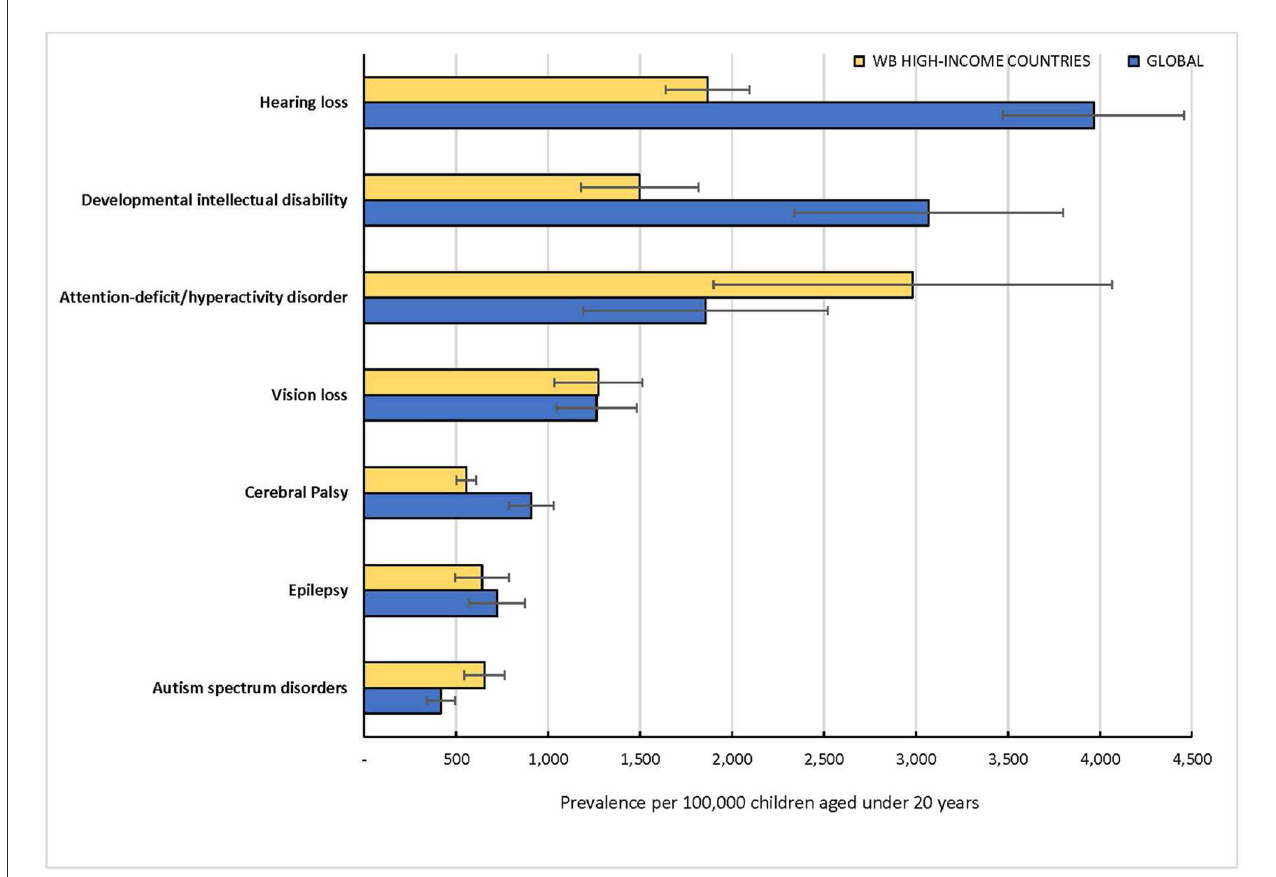
FIGURE2 Prevalence estimates of selected developmental disabilities in children under 20 years in 2019 by the Global Burden of Disease (GBD) Study Group.